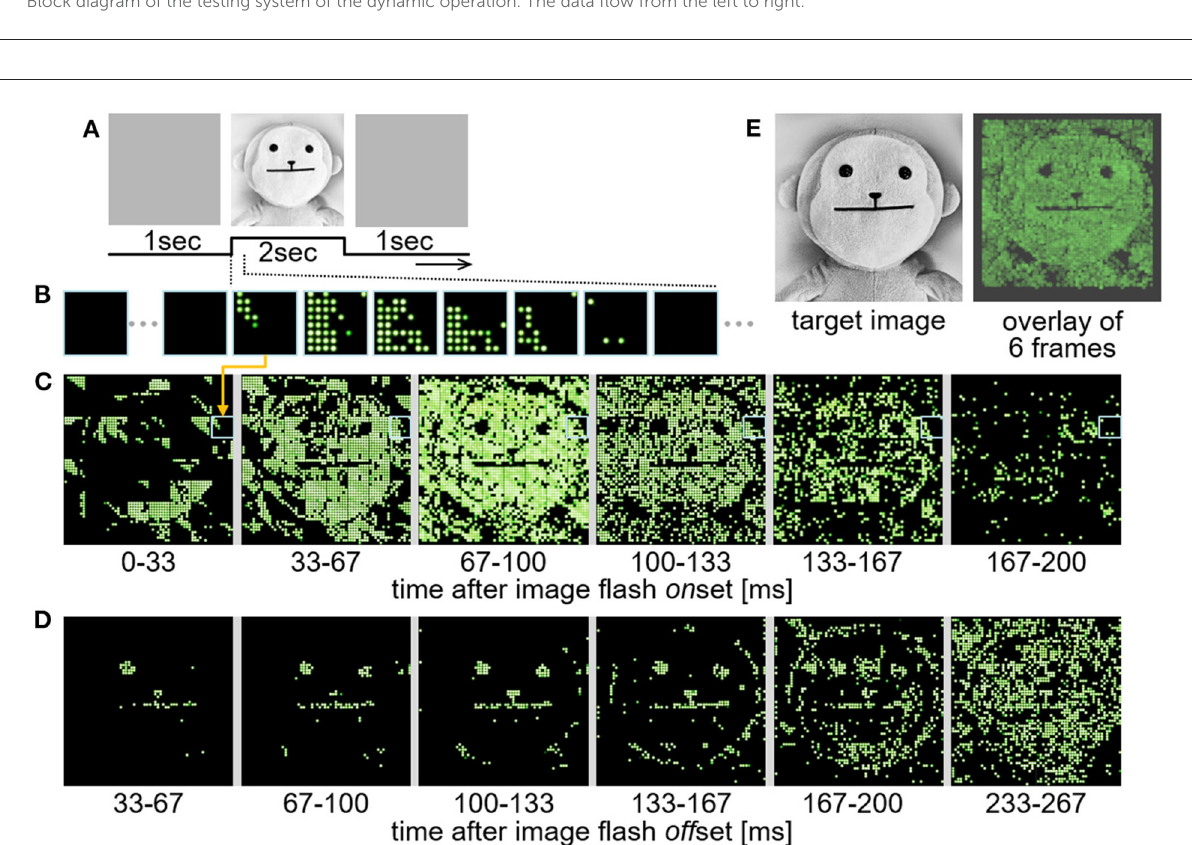
FIGURE11 Demonstration test of the real time dynamic operation. (A) Image flash stimulation applied to the retinal circuit emulator. An image of a doll was displayed for 2 seconds after a full-field gray image. (B) An example of time-lapse images of the 8-by-8 LED lighting patterns generated by the current outputs from the stimulation module. Each of these images are digital photographs captured at ∼ 30 fps by a camcorder. (C,D) Combined time-lapse images of 64 of the 8-by-8 LED lighting patterns generated by the stimulation module after the onset (C) and the offset (D) of the image flash stimulation. (E) Comparison between the target image (left) and the resulting LED lighting pattern (right) in which 6 image frames shown in (C) are